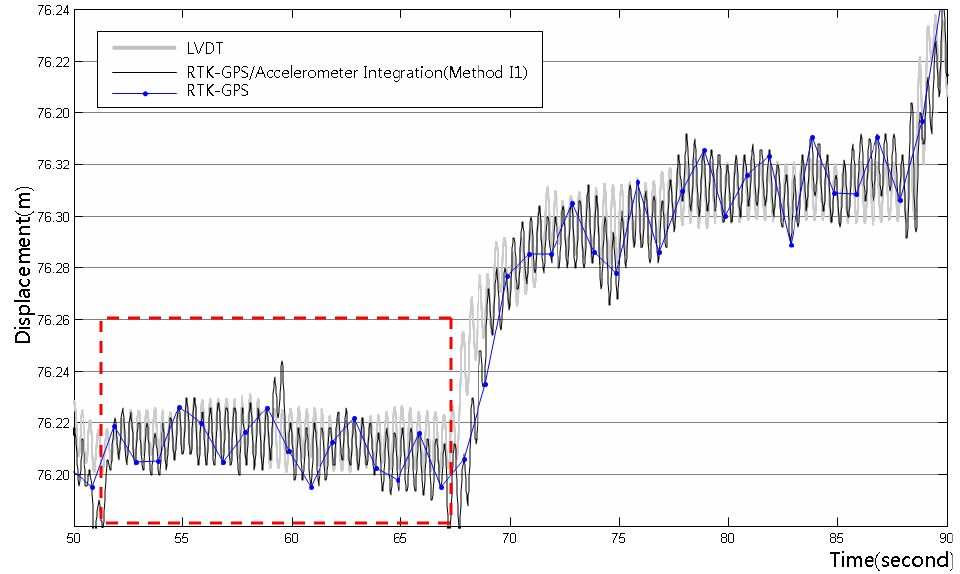
Figure 14. LVDT measurements, RTK-GPS/accelerometer integrated calculation results (Method I1), and long-frequency displacements from the RTK-GPS measurements.